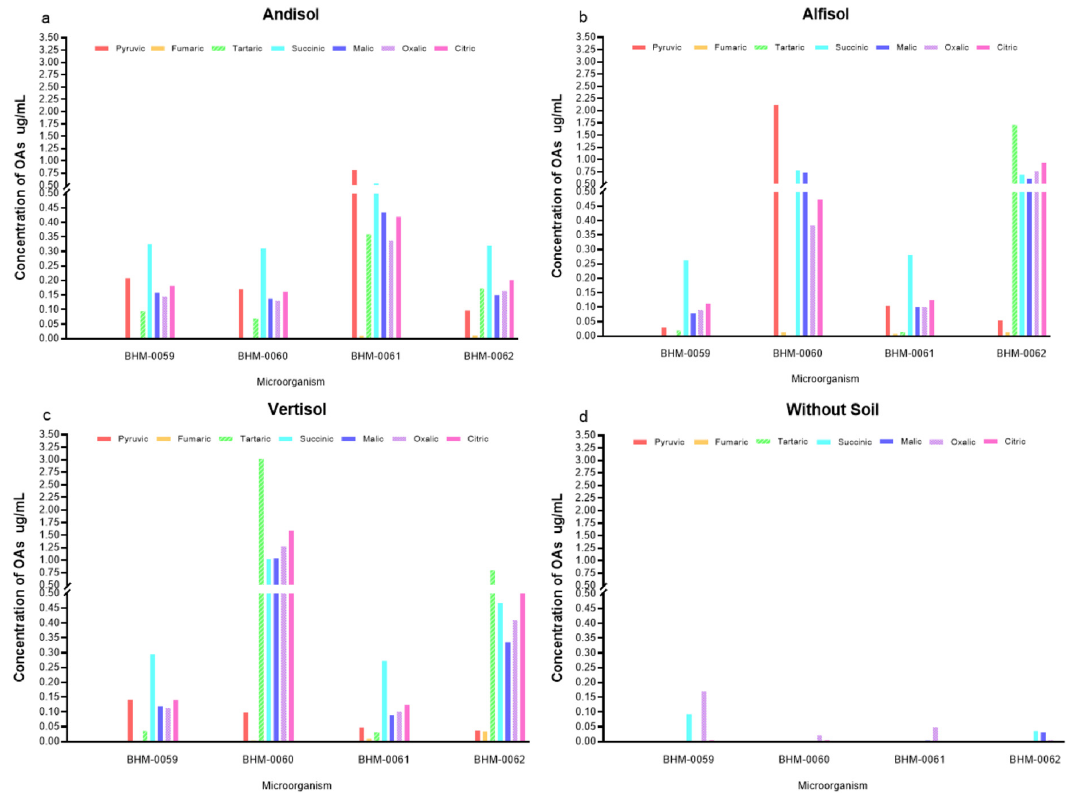
Figure 3. Profile of OAs produced by different fungi when incubated in different soils. Three types of soils were evaluated: ( a ) Andisol, ( b ) Alfisol, ( c ) Vertisol, and ( d ) a control Without Soil (WS). Strains BMH-0059, BMH-0060, BMH-0061, BMH-0062 were tested. All values shown are the average of four replicates per treatment. ( P ≤ 0.01).